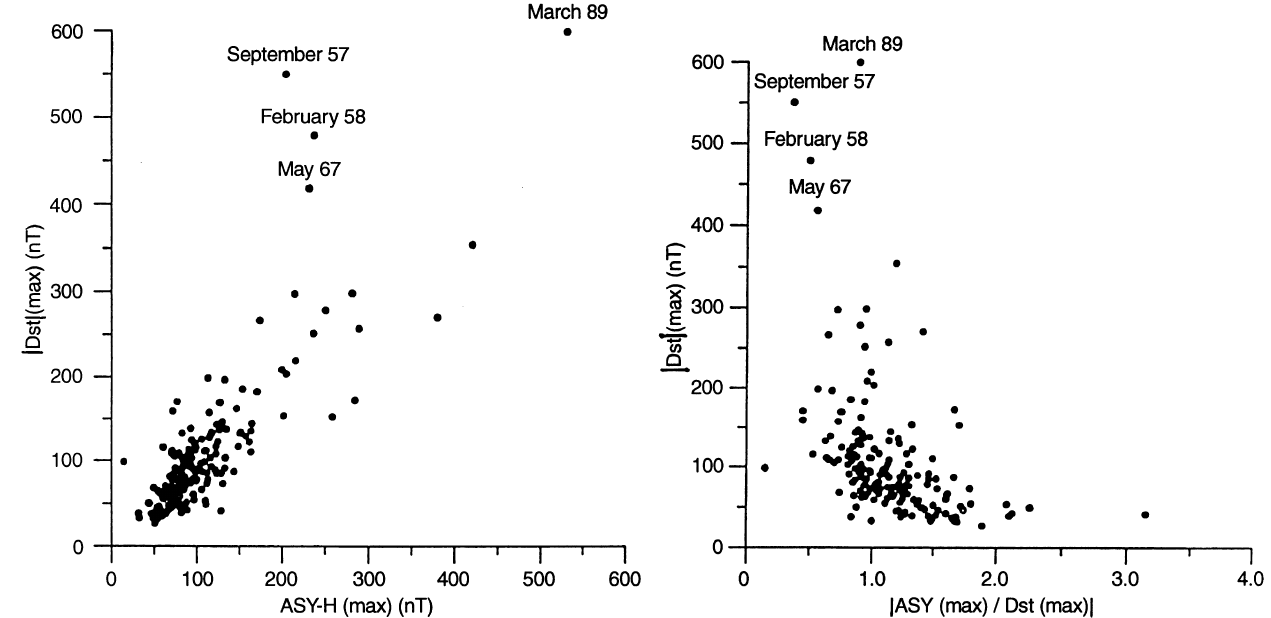
Fig. 5. Relationship between maximum j Dst j and ASY and maximum j Dst j and j ASY = Dst j during the storm maim phase (1989–1995 and some very strong